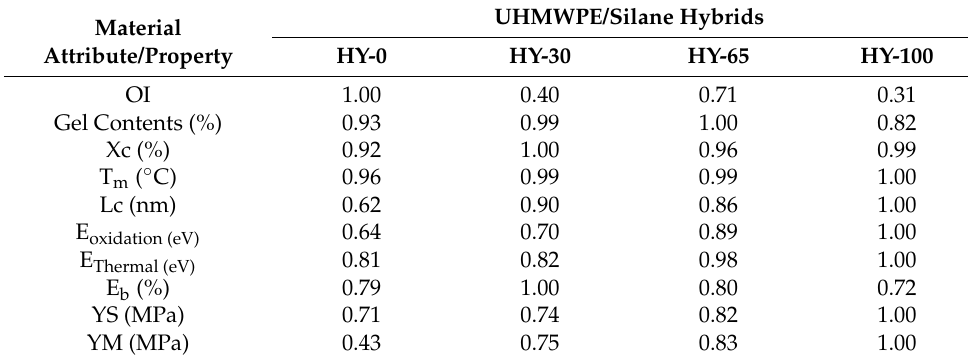
Table 3 indicates the normalization of the structures and performance attributes. Table 3. Normalization of structure and performance attributes.